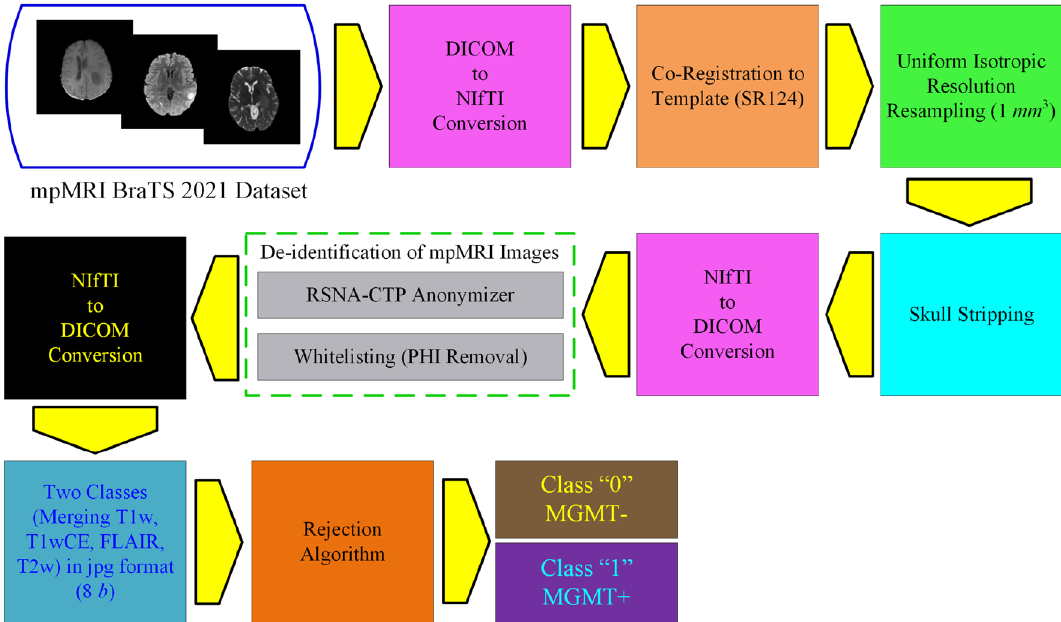
Figure 3. Efficient preprocessing steps for BraTS-2021 for mpMRI scans to MGMT methylation prediction